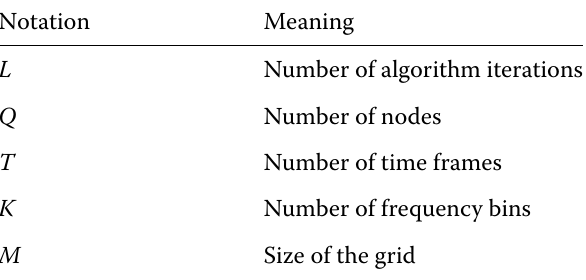
Table 1 Implementation